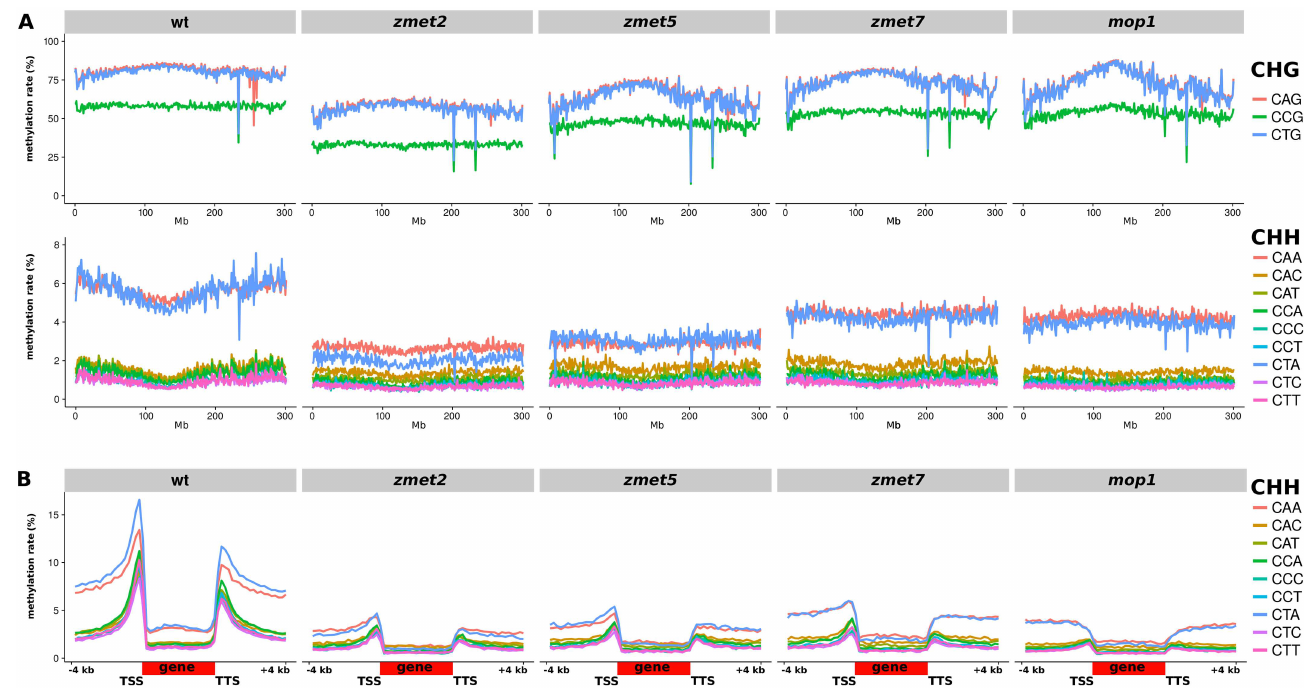
Fig 6. Maize DNA methylation in CMT and RdDM mutants. (A) CHG and CHH subcontext methylationalong chromosome 1. (B) Average CHH subcontextmethylationover genes. CHH islands[11] are clearly visible upstream of the transcriptional start site (TSS) and downstreamof the transcription terminationsite (TTS), and dependboth on RdDM and CMT